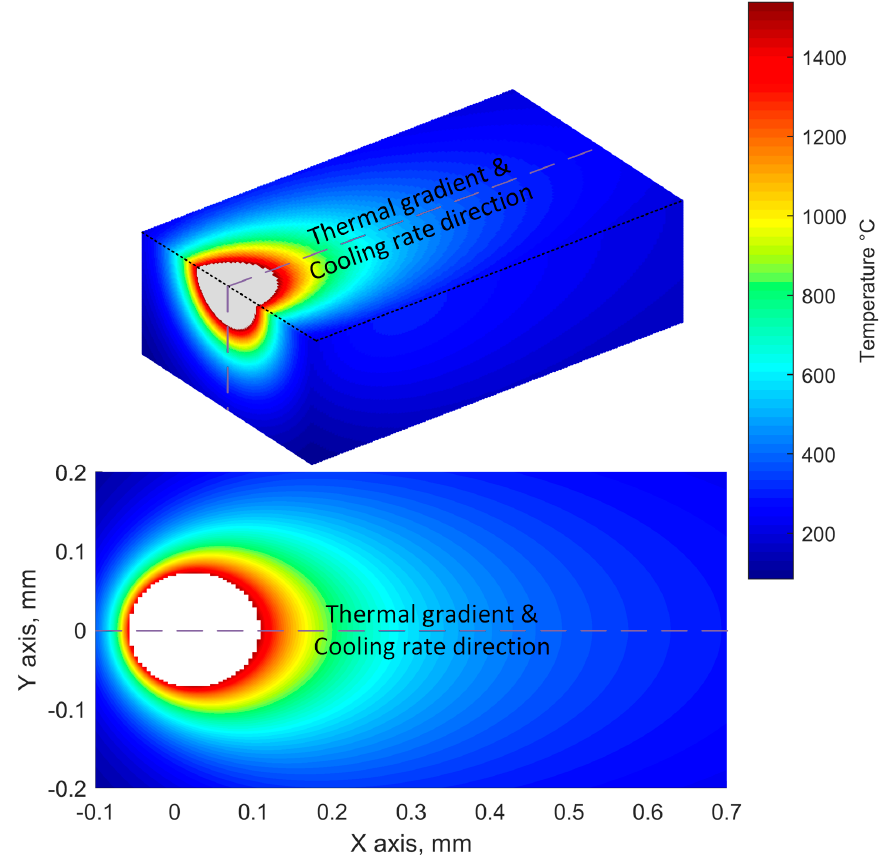
Figure 3. Calculated melt pool for iron powder when P = 270 W, v = 1500 mm/s, and t = 40 μ m.